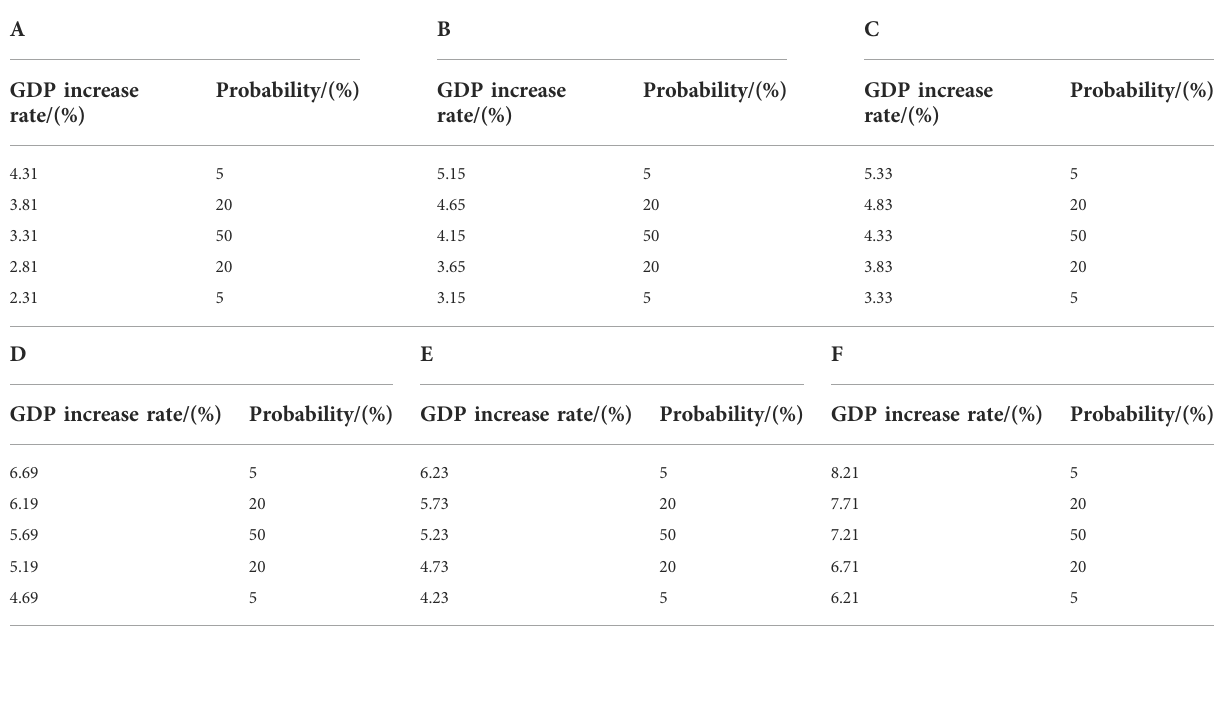
TABLE 8 Parameters of Monte-Carlo simulation.